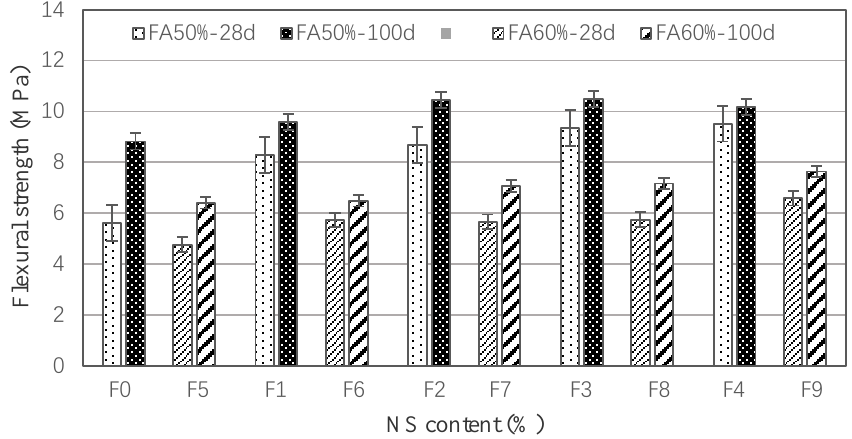
Figure 5. Flexural strength of NS-modified mortar.